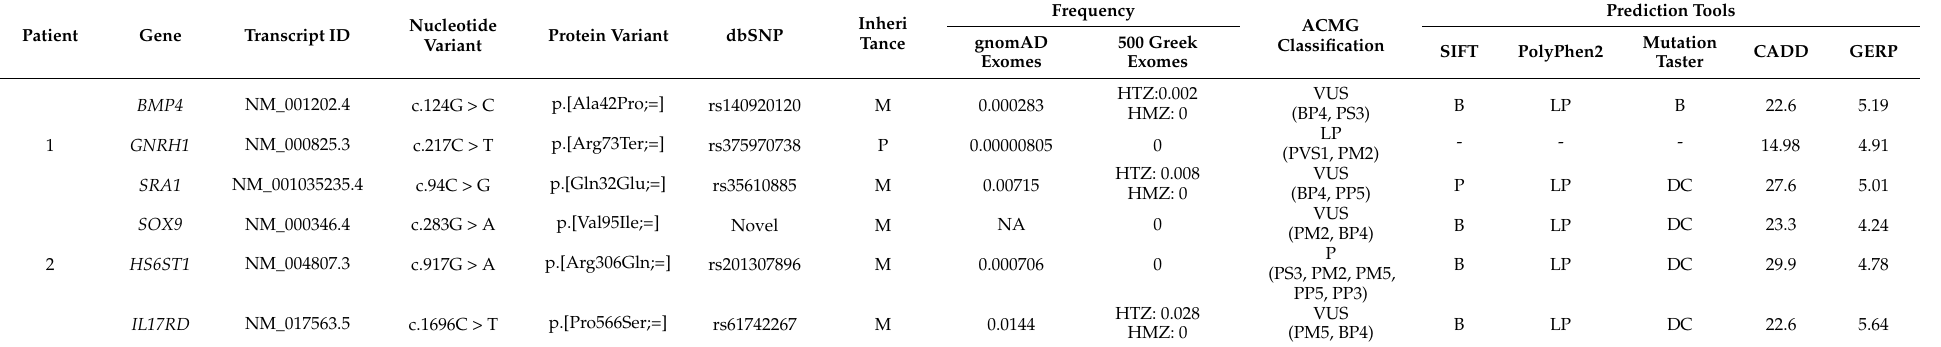
Table 2. Pathogenic variants detected by WES and their interpretation by some of the used bioinformatic